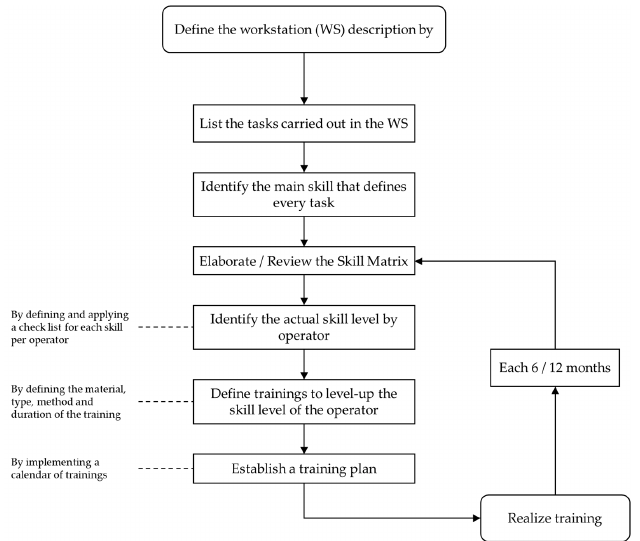
Figure 6. Skill matrix flow. [Source: inspired by the chapter “Skill management” (pages 113–119) in reference [12]].